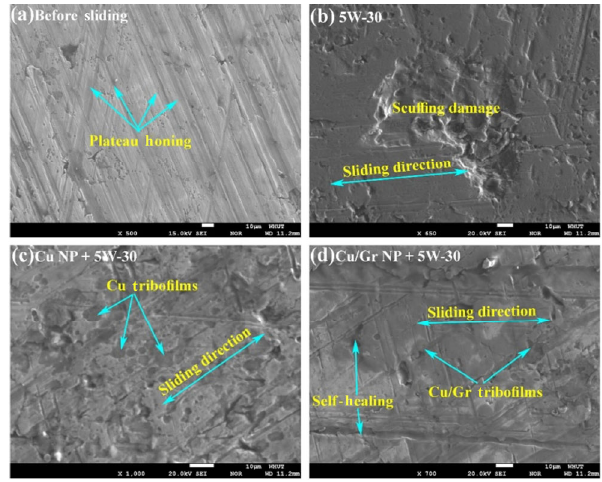
Fig. 8 EPMA images of the frictional surface of the cylinder liner when lubricated by the reference oil and nano-additives.